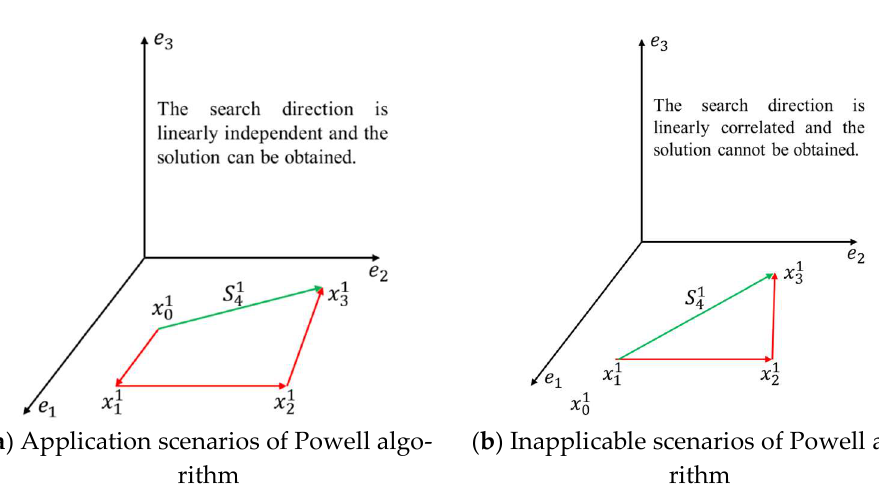
Figure 5. Characteristic analysis of traditional Powell algorithm.